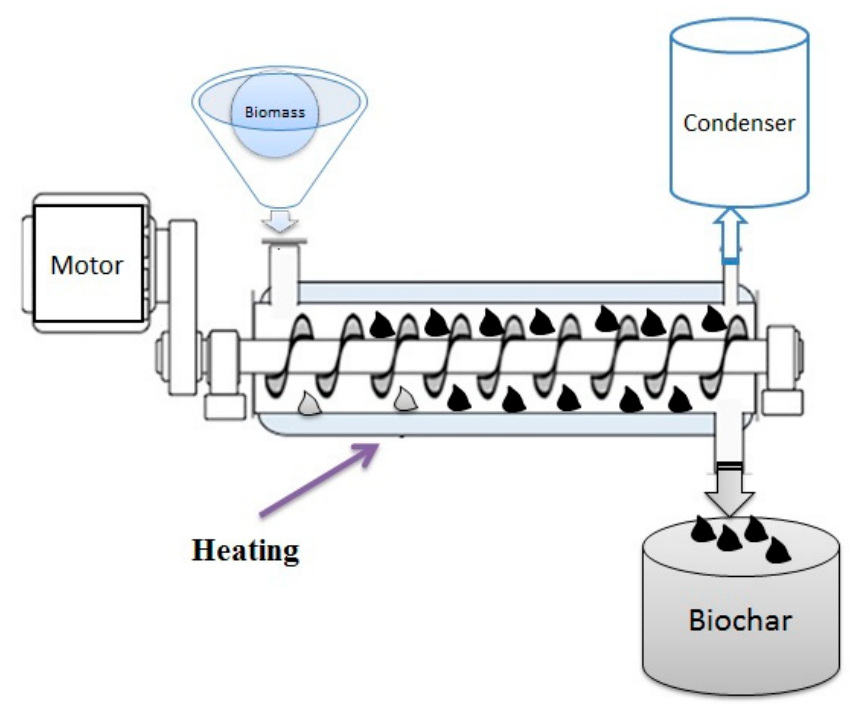
Figure 2. Simple illustration of pyrolysis method.